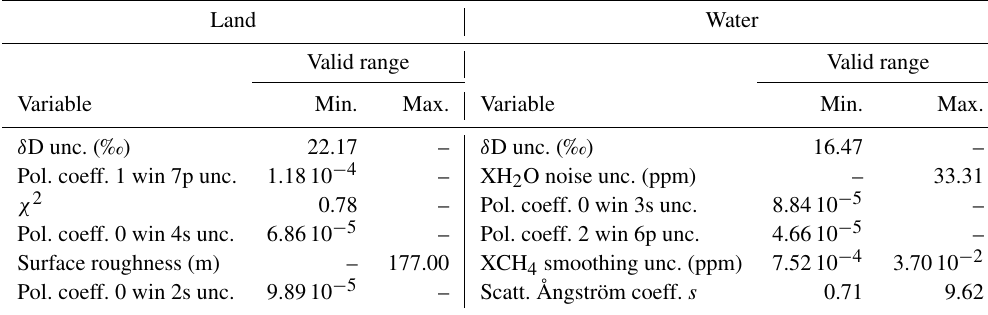
Table A9. XH 2 O filter variables and limits for GOSAT-2. “–” means that no limit is applied. The variables are ordered by their relevance, i.e. by the number of data filtered out.